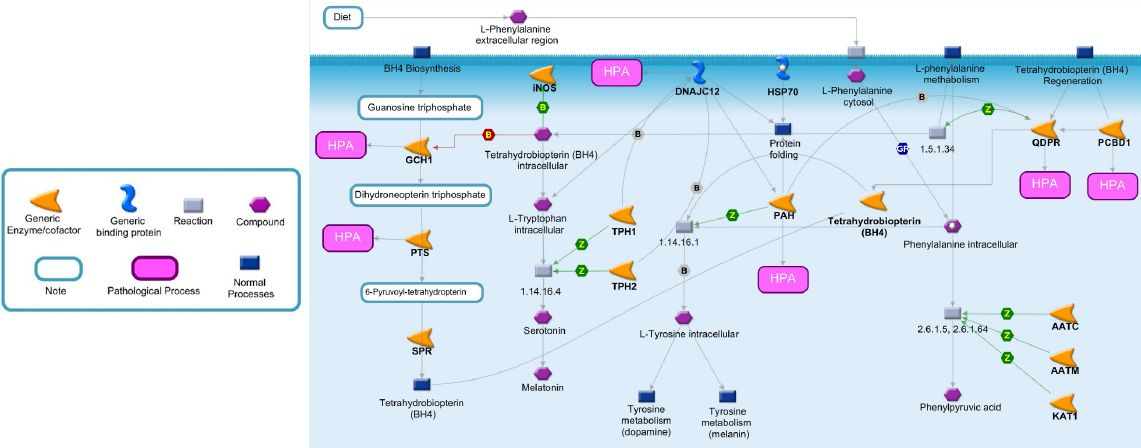
Figure 1. Metabolic pathway of Phe and BH4. Phe metabolism is crucial for protein synthesis, as well as for the synthesis of Tyr and its derivatives. The major catabolic pathway involves Phe hydroxylation to Tyr by PAH. In one of the minor pathways, Phe may undergo conversion to Phenylpyruvic acid. An essential cofactor and regulator of PAH is BH4, whose biosynthesis and regeneration depend by different enzymes. Abbreviations: AATC, Aspartate aminotransferase, cytoplasmic; AATM, Aspartate aminotransferase, mitochondrial; DCoH, Pterin-4-alpha-carbinolamine dehydratase; DHPR, Dihydropteridine reductase; DNAJC12, DNAJ homolog subfamily C member 12; GCH1, Guanosine triphosphate (GTP) cyclohydrolase 1; KAT1, Kynurenine-oxoglutarate transaminase 1; PAH, Phenylalanine-4-hydroxylase; PTS, 6-pyruvoyl tetrahydrobiopterin synthase; SPR, Sepiapterin reductase; TPH1, Tryptophan 5-hydroxylase 1; TPH2, Tryptophan 5-hydroxylase 2; PCBD1, Pterin-4a-carbinolamine dehydratase; EC number 1.5.1.34: Dihydrobiopterin + NADH = NAD + + Tetrahydrobiopterin; EC number 1.14.16.1: O 2 + Tetrahydrobiopterin + S-Methylcysteine = S- Methylcysteine-sulfoxide + H 2 O + Dihydrobiopterin; EC number: 1.14.16.4 L-Tryptophan + O 2